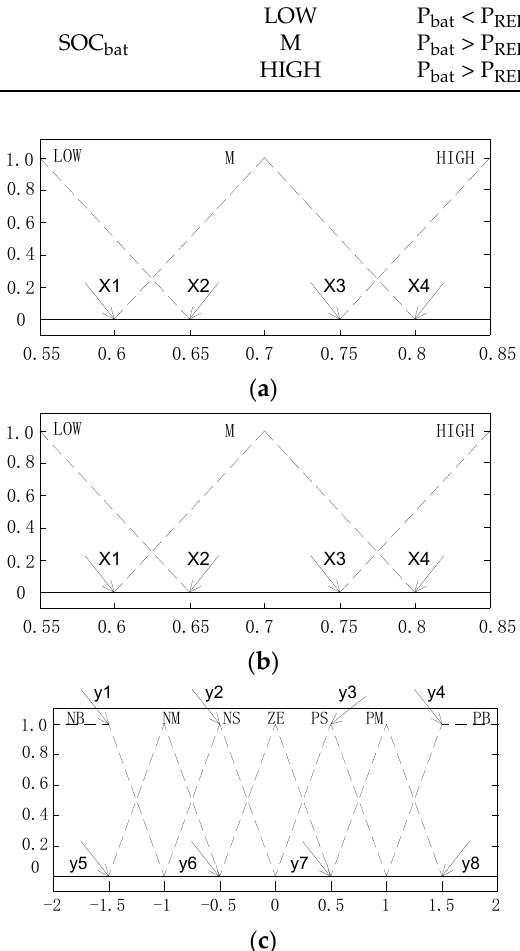
Figure 13. Membership functions: ( a ) SOCuc ( b ) SOCbat ( c ) PREF-bat.